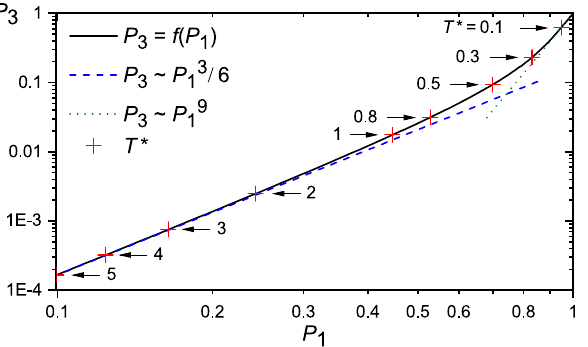
Figure 7. Log-log plot of parametric relation between order parameters P 3 and P 1 (black solid line). The 1 /β ⋆ reduced temperature parameter T ⋆ d is marked along the curve. The high-temperature asymptote = P 3 ( P 1 ) 3 / 6 (blue dashed line) and low-temperature asymptote P 3 ( P 1 ) 9 (green dotted line) are also = =